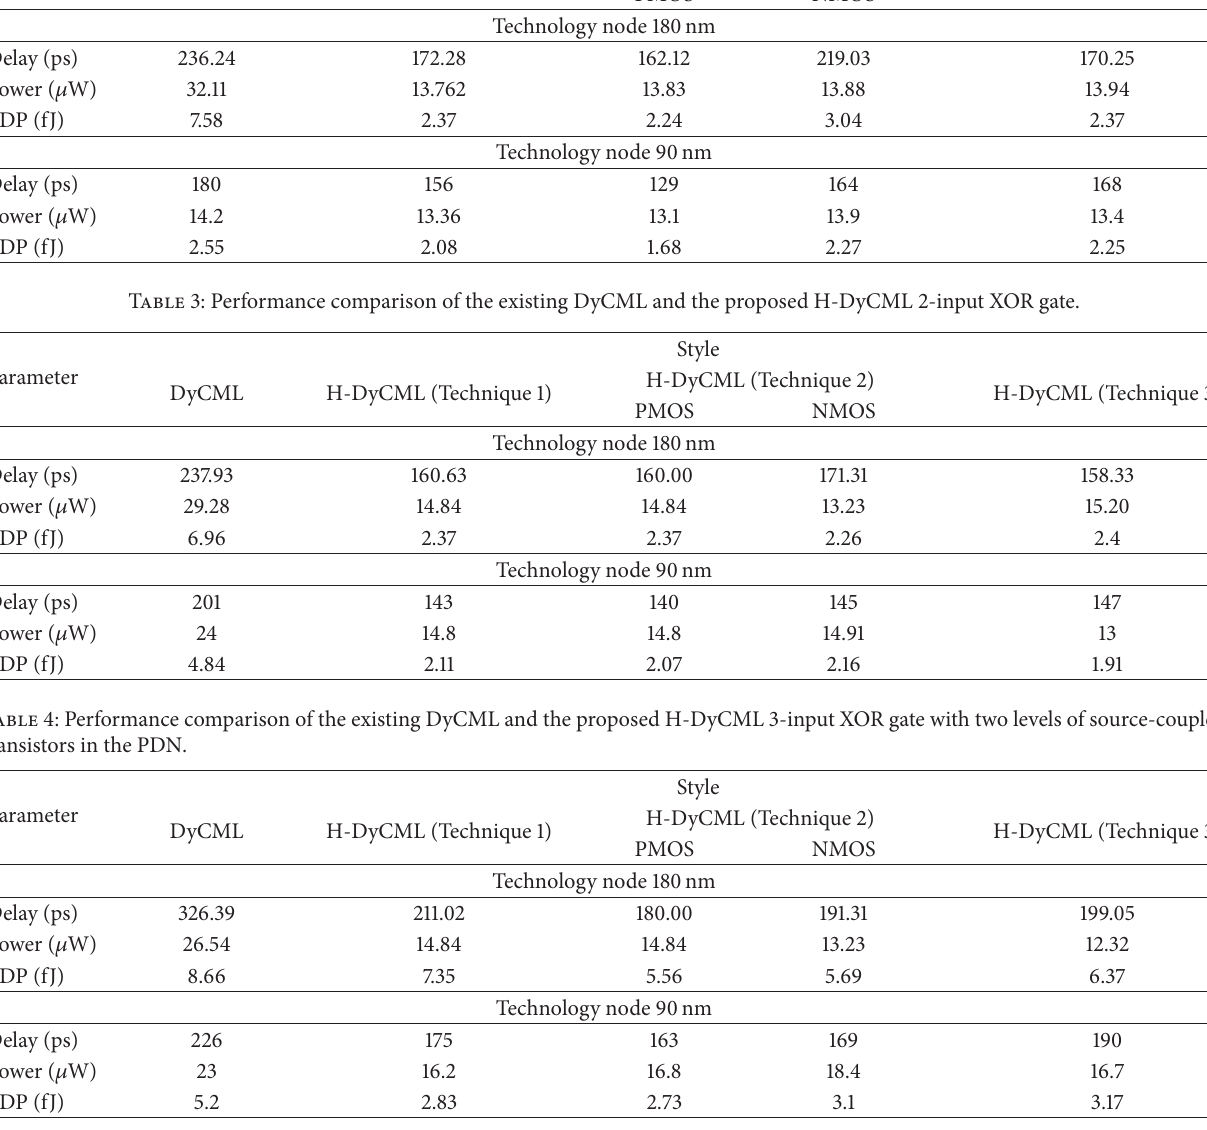
Table 2: Performance comparison of the existing DyCML and the proposed H-DyCML OR gate. Parameter